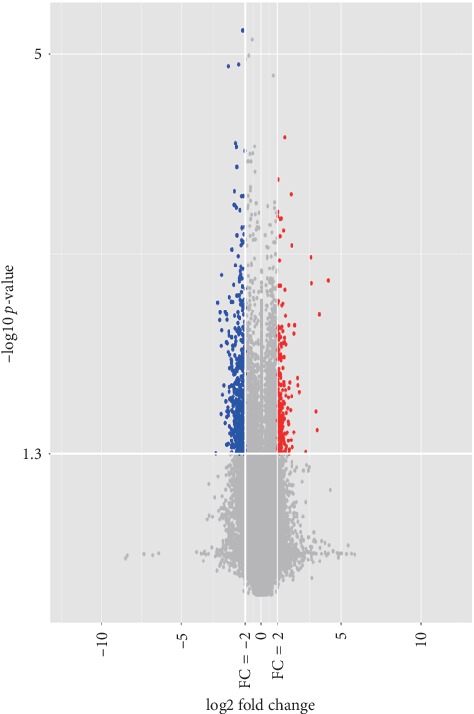
Volcano plot analysis of the microarray chip data on the differentially expressed plasma exosomal lncRNAs between coronary artery disease (CAD) patients and controls. The vertical white line corresponds to a 2.0-fold up- and downregulation while the horizontal white line represents a P value of 0.05. The red and blue dots indicate more than a 2.0-fold change and represent the differentially expressed genes with statistical significance.